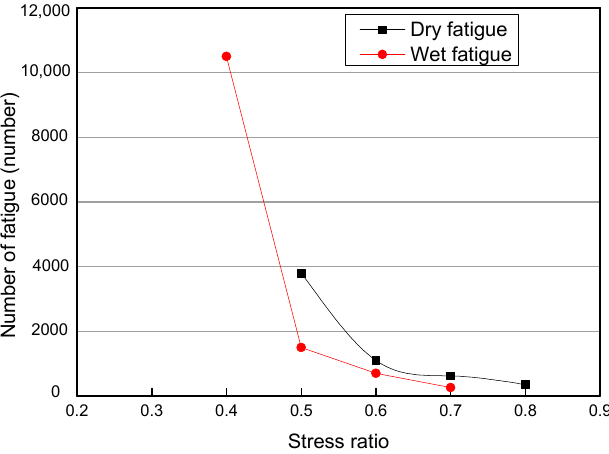
Figure 6. Comparison of dry and wet fatigue times.